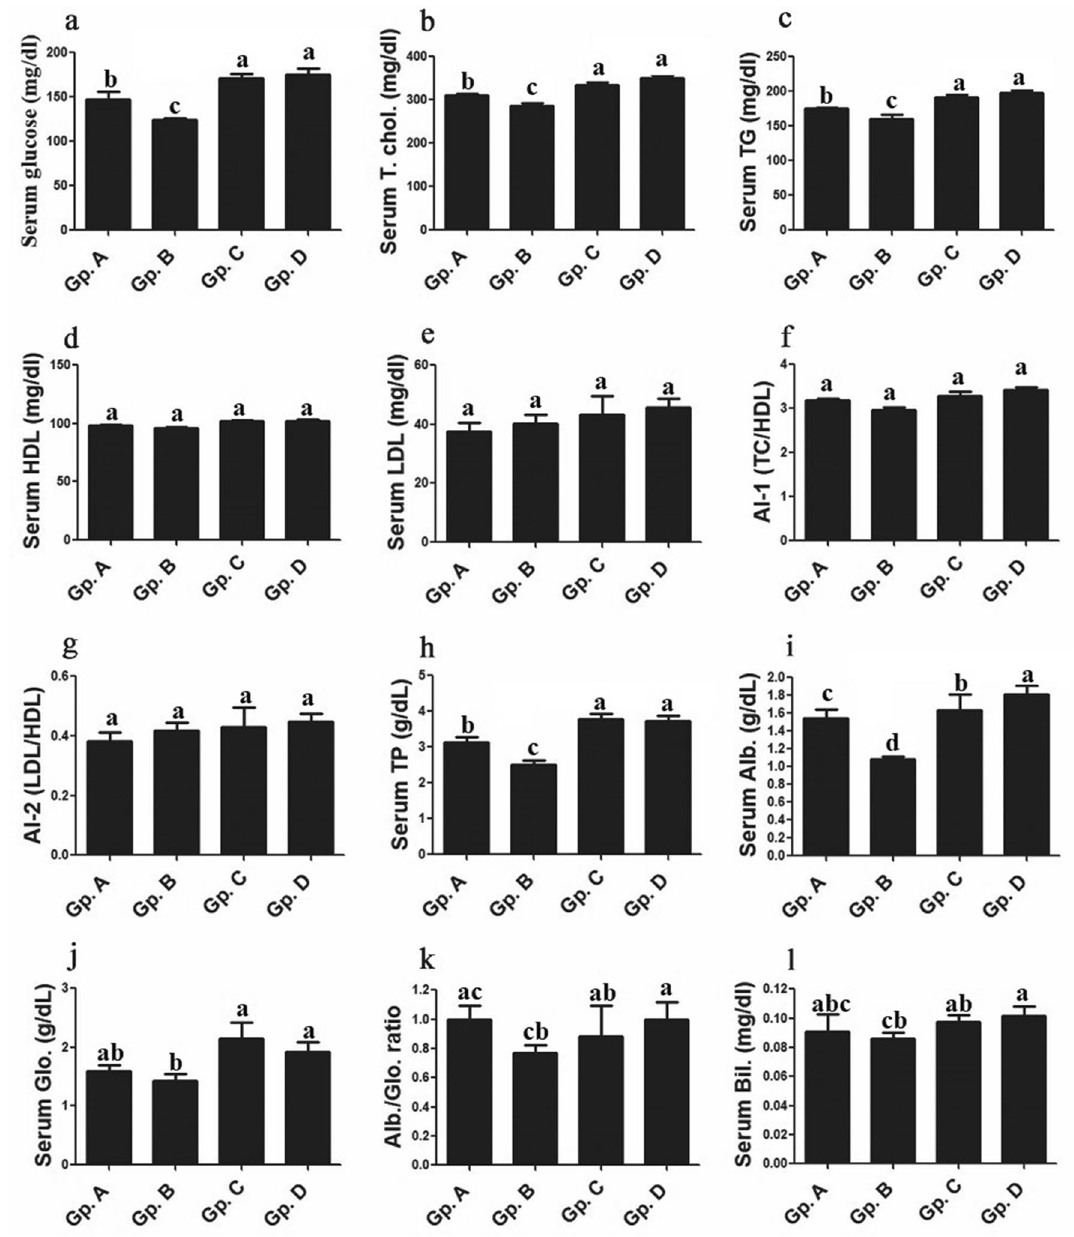
Figure 3. Effect of temperature changes on some biochemical parameters ( a : glucose, b : T. chol.; c : TG; d : HDL; e : LDL; f : AI-1; g : AI-2; h : TP; i : Alb.; j : Glo.; k : Alb./Glo. Ratio, & l : Bil.) in the different experimental groups of Dabb lizard ( U. aegyptia ). Data were expressed as mean ± SE. Gp. A: control group; Gp. B: low temperature exposed group; Gp. C: moderate temperature exposed group; Gp. D: high temperature exposed group; TC: total cholesterol; TG: triglyceride; HDL: high-density lipoprotein; LHD: low-density lipoprotein; AI-1: atherogenic index 1 (TC/HDL); AI-2: atherogenic index 2 (LDL/HDL); TP: total protein; Alb.: albumin; Glo.: globulin; Bil.: bilirubin. abcd Means above each bar with different letters in different Dabb groups i.e. Gp. A, Gp. B, Gp. C and Gp. D, were significantly different ( P <